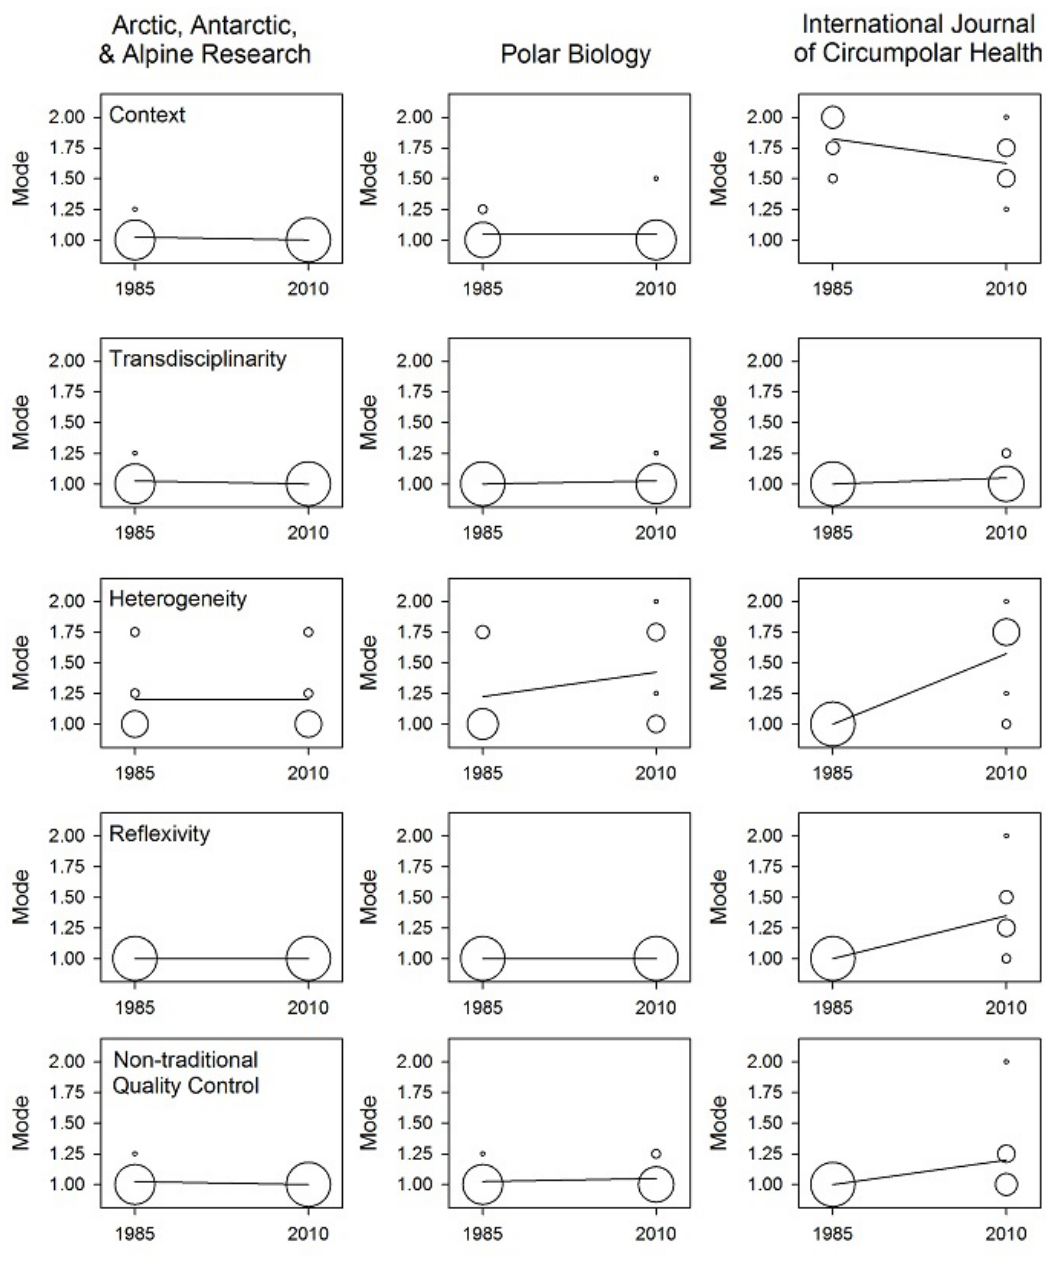
Fig. 6 . Patterns in the Mode of knowledge production in Arctic science and Mode 2 approaches in 1985 and 2010 in our analysis of research papers published in the journals AAAR, IJCH, and Polar Biology. Circles are bubbles, with size reflective of the proportion of studies in that